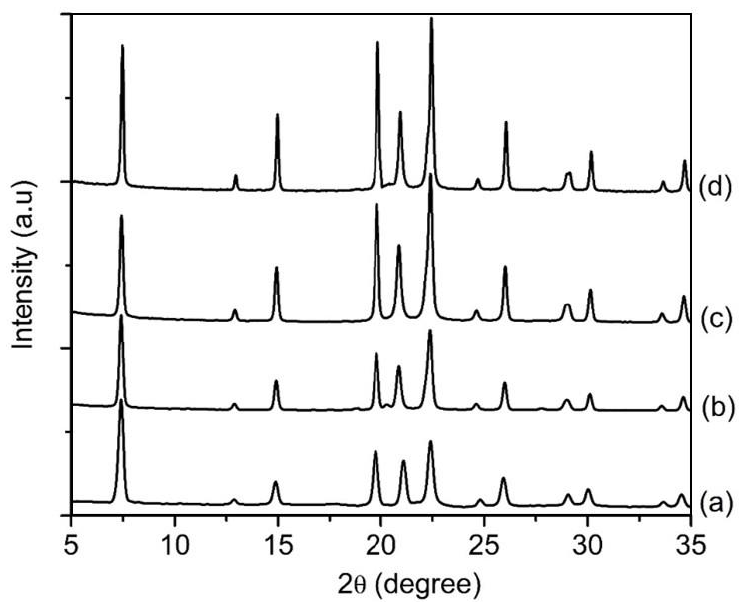
Figure 9. XRD patterns of ( a ) SH15 ( z = 0), ( b ) SH16 ( z = 0.23), ( c ) SH4 ( z = 0.47) and ( d ) SH17 ( y = 0.70) prepared with a molar composition of 1Al 2 O 3 :2.5P 2 O 5 :2.5[bzmIm] 2 O:180H 2 O: z SiO 2 heated at 150 °C for 10 h.